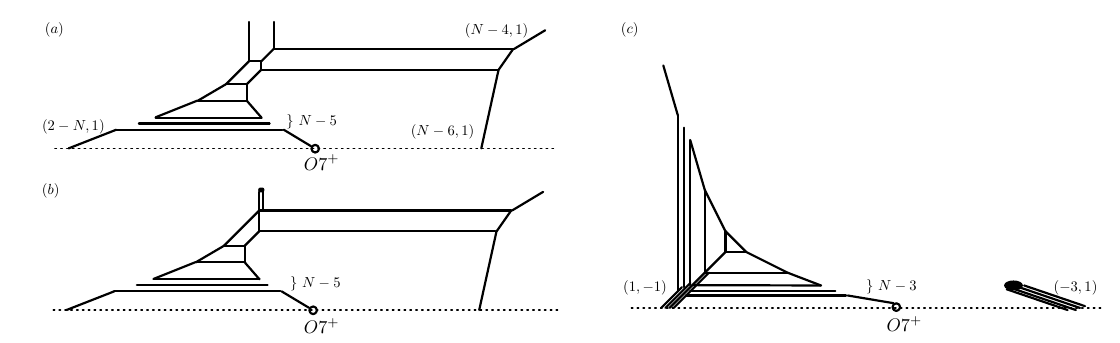
+ 1 Sym , where there are N D5-branes in total. (b) 2